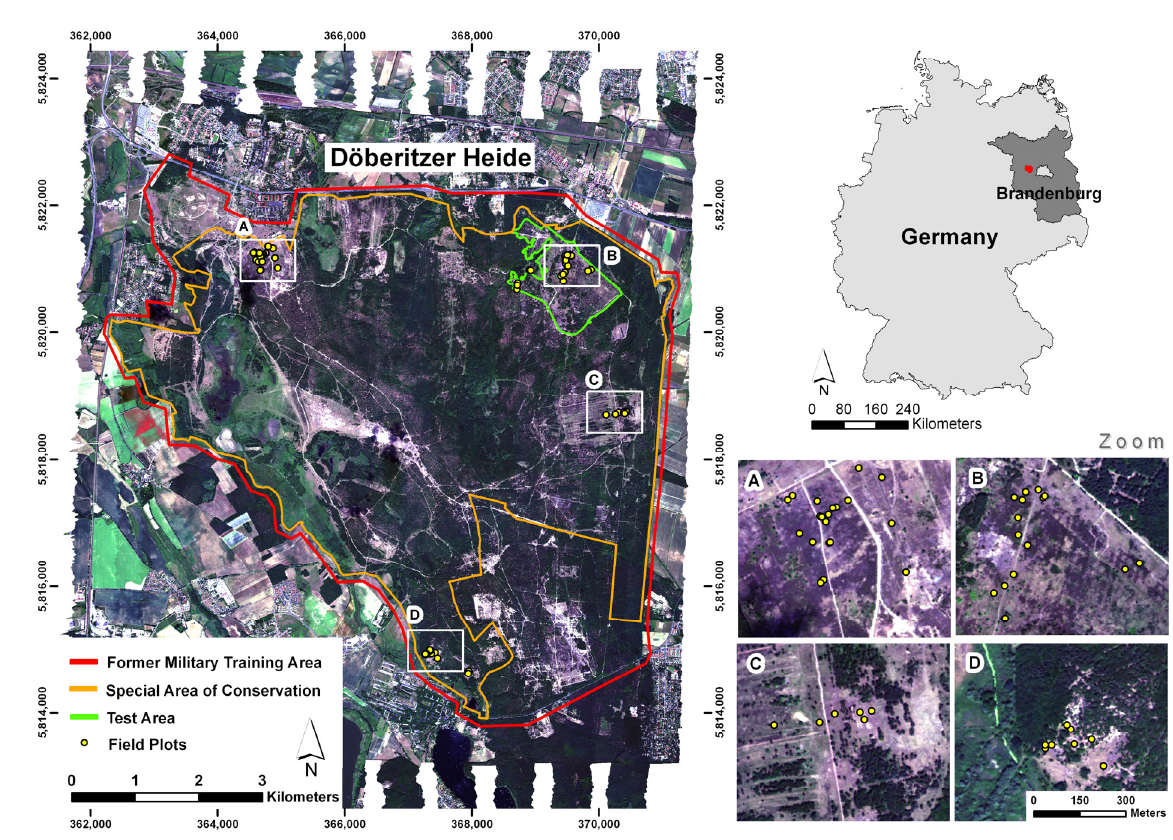
Figure 1. The former military training area Döberitzer Heide, visualized on flight stripes of the hyperspectral airplane campaign; field plots for plant species sampling are distributed in four open dryland areas; the test area for spatially explicit model transfer is marked in